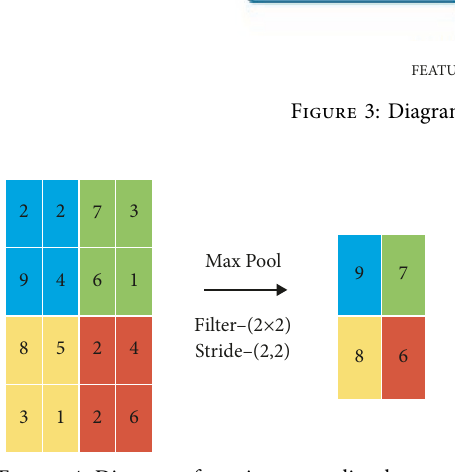
Figure 4: Diagram of maximum pooling layer.